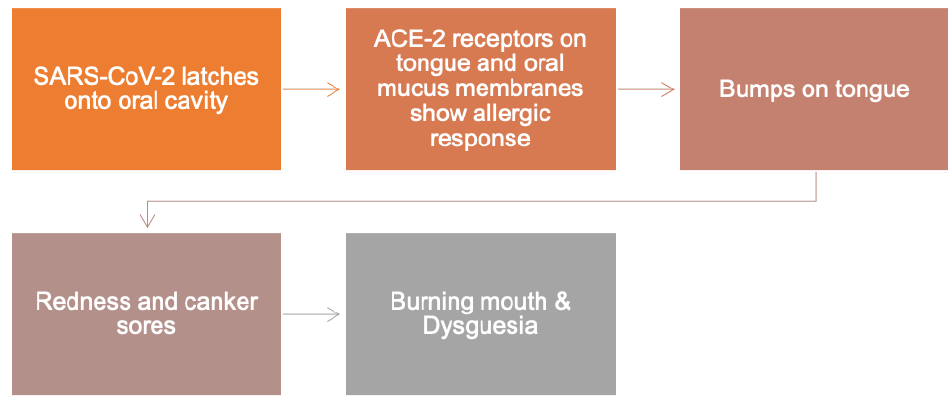
Figure 5. SARS-CoV-2 mechanism of oral manifestations. Reprinted with permission from